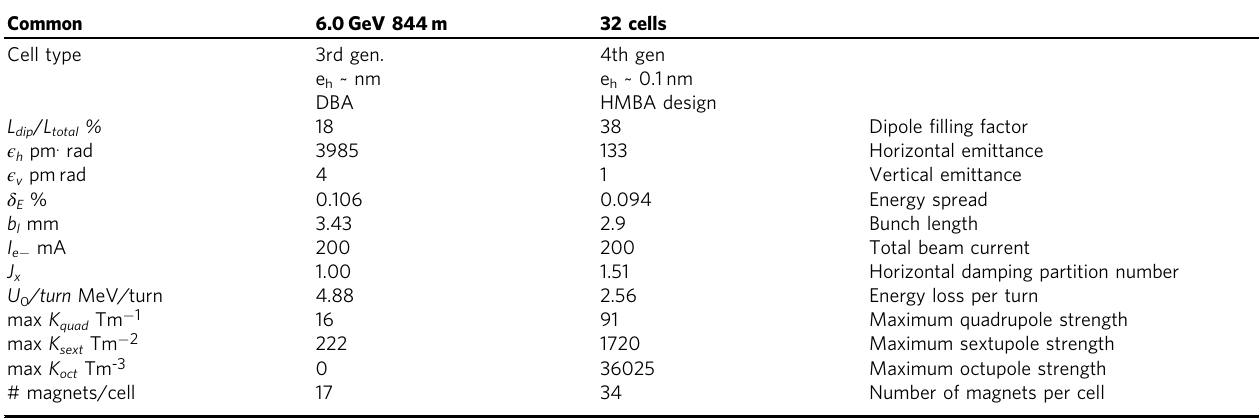
Table 1 Comparison of DBA and HMBA source parameters. Common